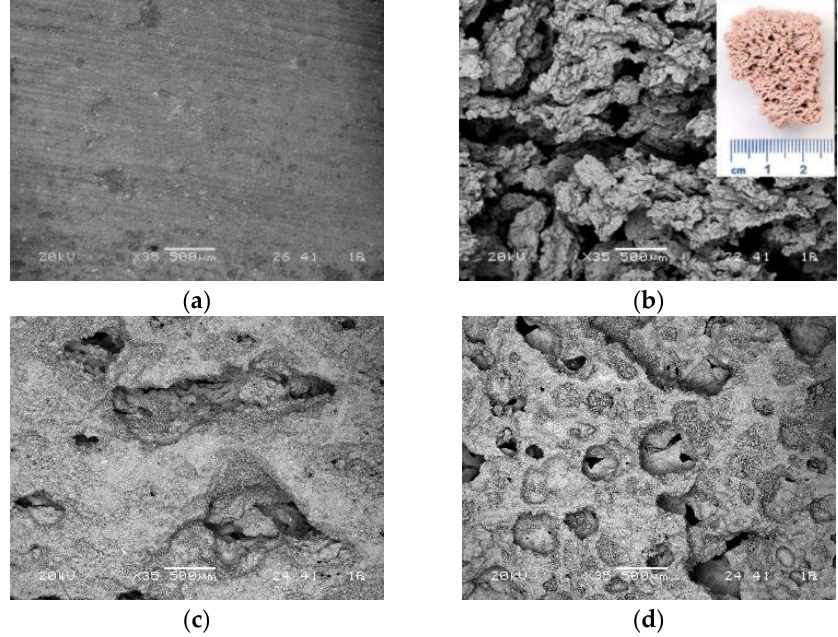
Figure 17. Dependence of the structure in SEM micrographs on small changes in preparation using mixture ζ 4 , Na-perborate as foaming agent and Na-dodecyl sulphate as stabilizing agent. ( a ) AAM (25 g of mixture ζ 4 ), ( b ) AAF with 5% of foaming agent, and 1% of stabilizing agent (25 g of mixture ζ 4 , 2.5 g of foaming agent, 0.5 g of stabilizing agent; on the inset is photography of the cross-cut sample), ( c ) AAF with lower amount of foaming agent (25 g of mixture ζ 4 , 0.5 g of foaming agent, 0.5 g of stabilizing agent), ( d ) AAF with additional liquid phase (40 g of mixture ζ 4 , 0.5 g of foaming agent, 0.5 g of stabilizing agent). All samples are cured on 70 °C for one day and measured one week after molding.